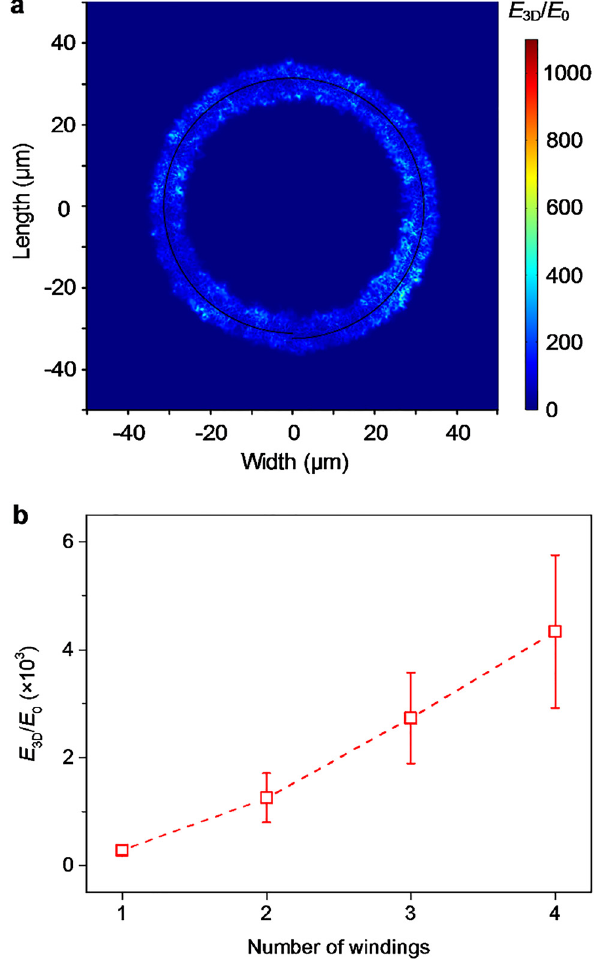
Figure 5: Simulation of the optical field of the 3D MoS 2 FETs. (a)Thedistributionoftheelectric fi eldmagnitudeclosetoa3DMoS 2 FET with one rolled-up winding, under the illumination by a surface light source with an operating wavelength of 395 nm and an electric fi eld magnitudeof E 0 =1V/m;(b)theaveragerelativeelectric fi eldmagnitude ( E 3D / E 0 ) at the surface of the 3D MoS 2 layer varies with the number of rolled-up windings of the 3D MoS 2 FETs. 3D, three-dimensional; FET, fi eld-effect transistor; MoS fi 2 , molybdenum disul